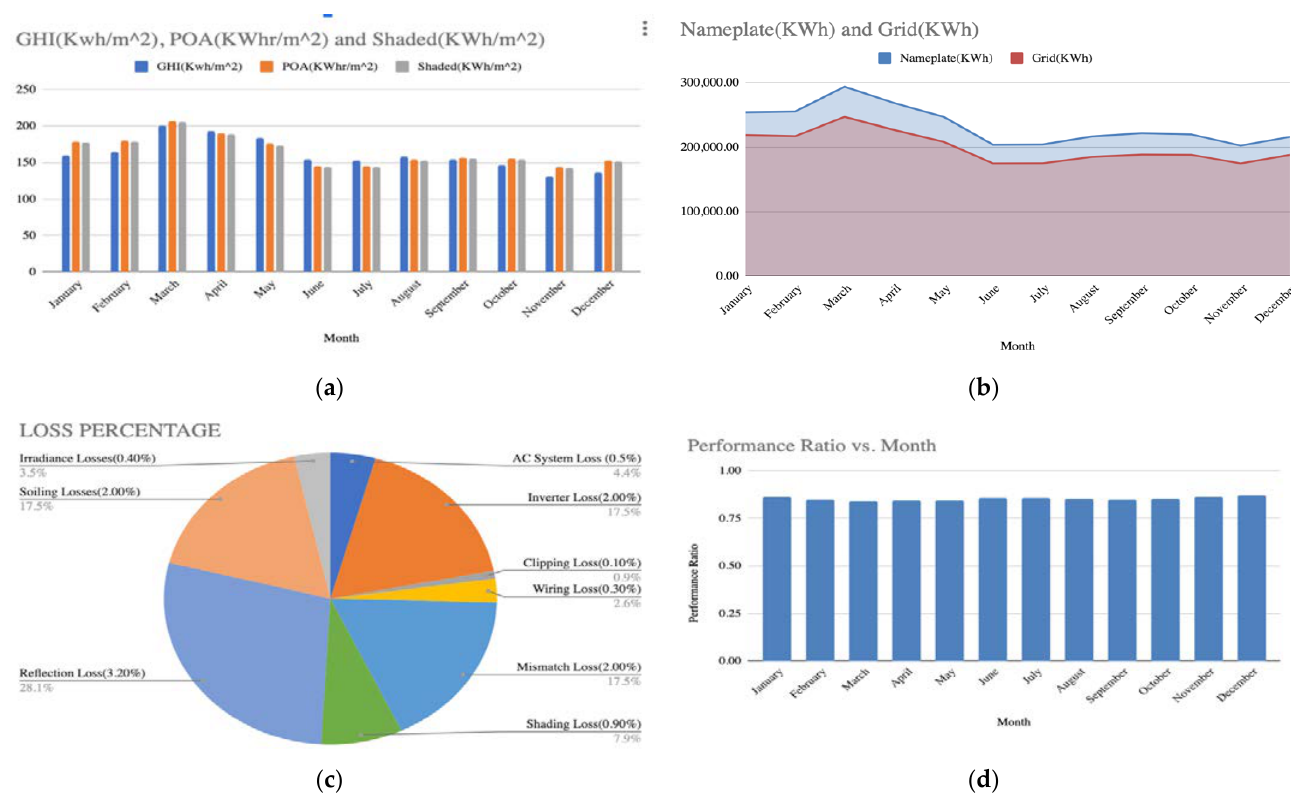
Figure 9. ( a ) GHI, POA and shaded radiation; ( b ) nameplate energy and grid energy; ( c ) loss % age; and ( d ) performance ratio.